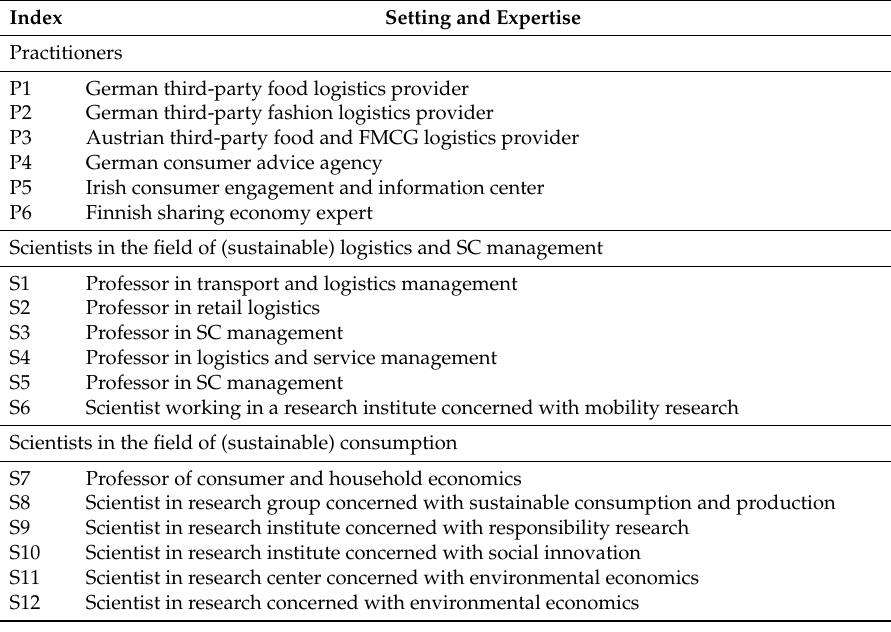
Table 2. Interviewee settings and